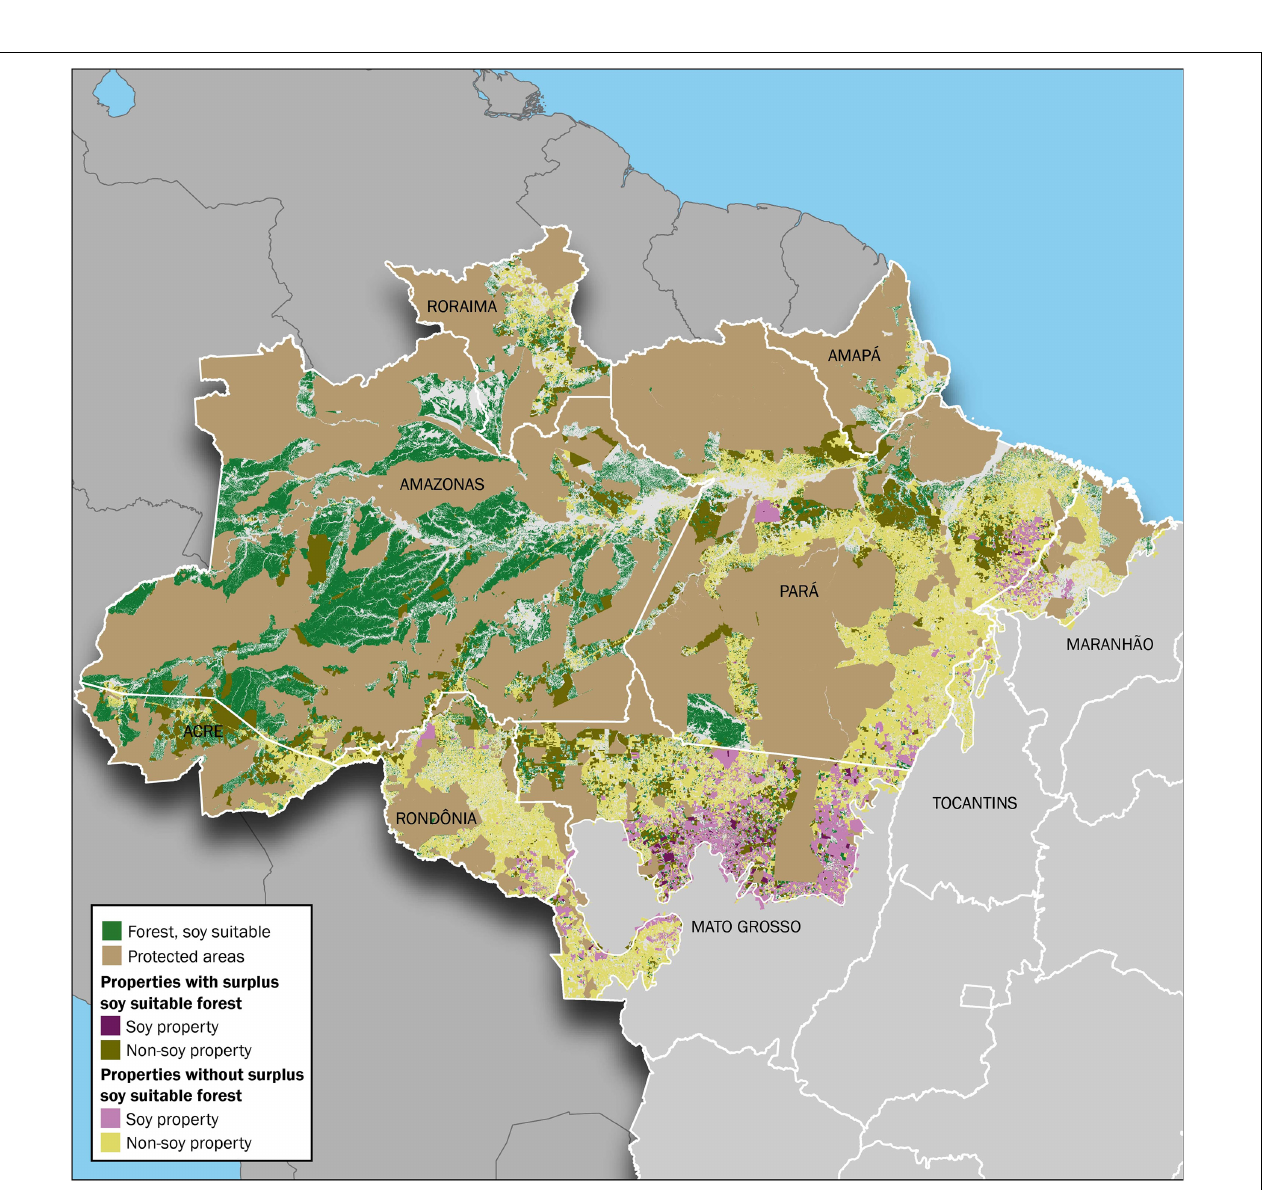
FIGURE 1 | Soy and non-soy producing properties with and without soy-suitable surplus forest.